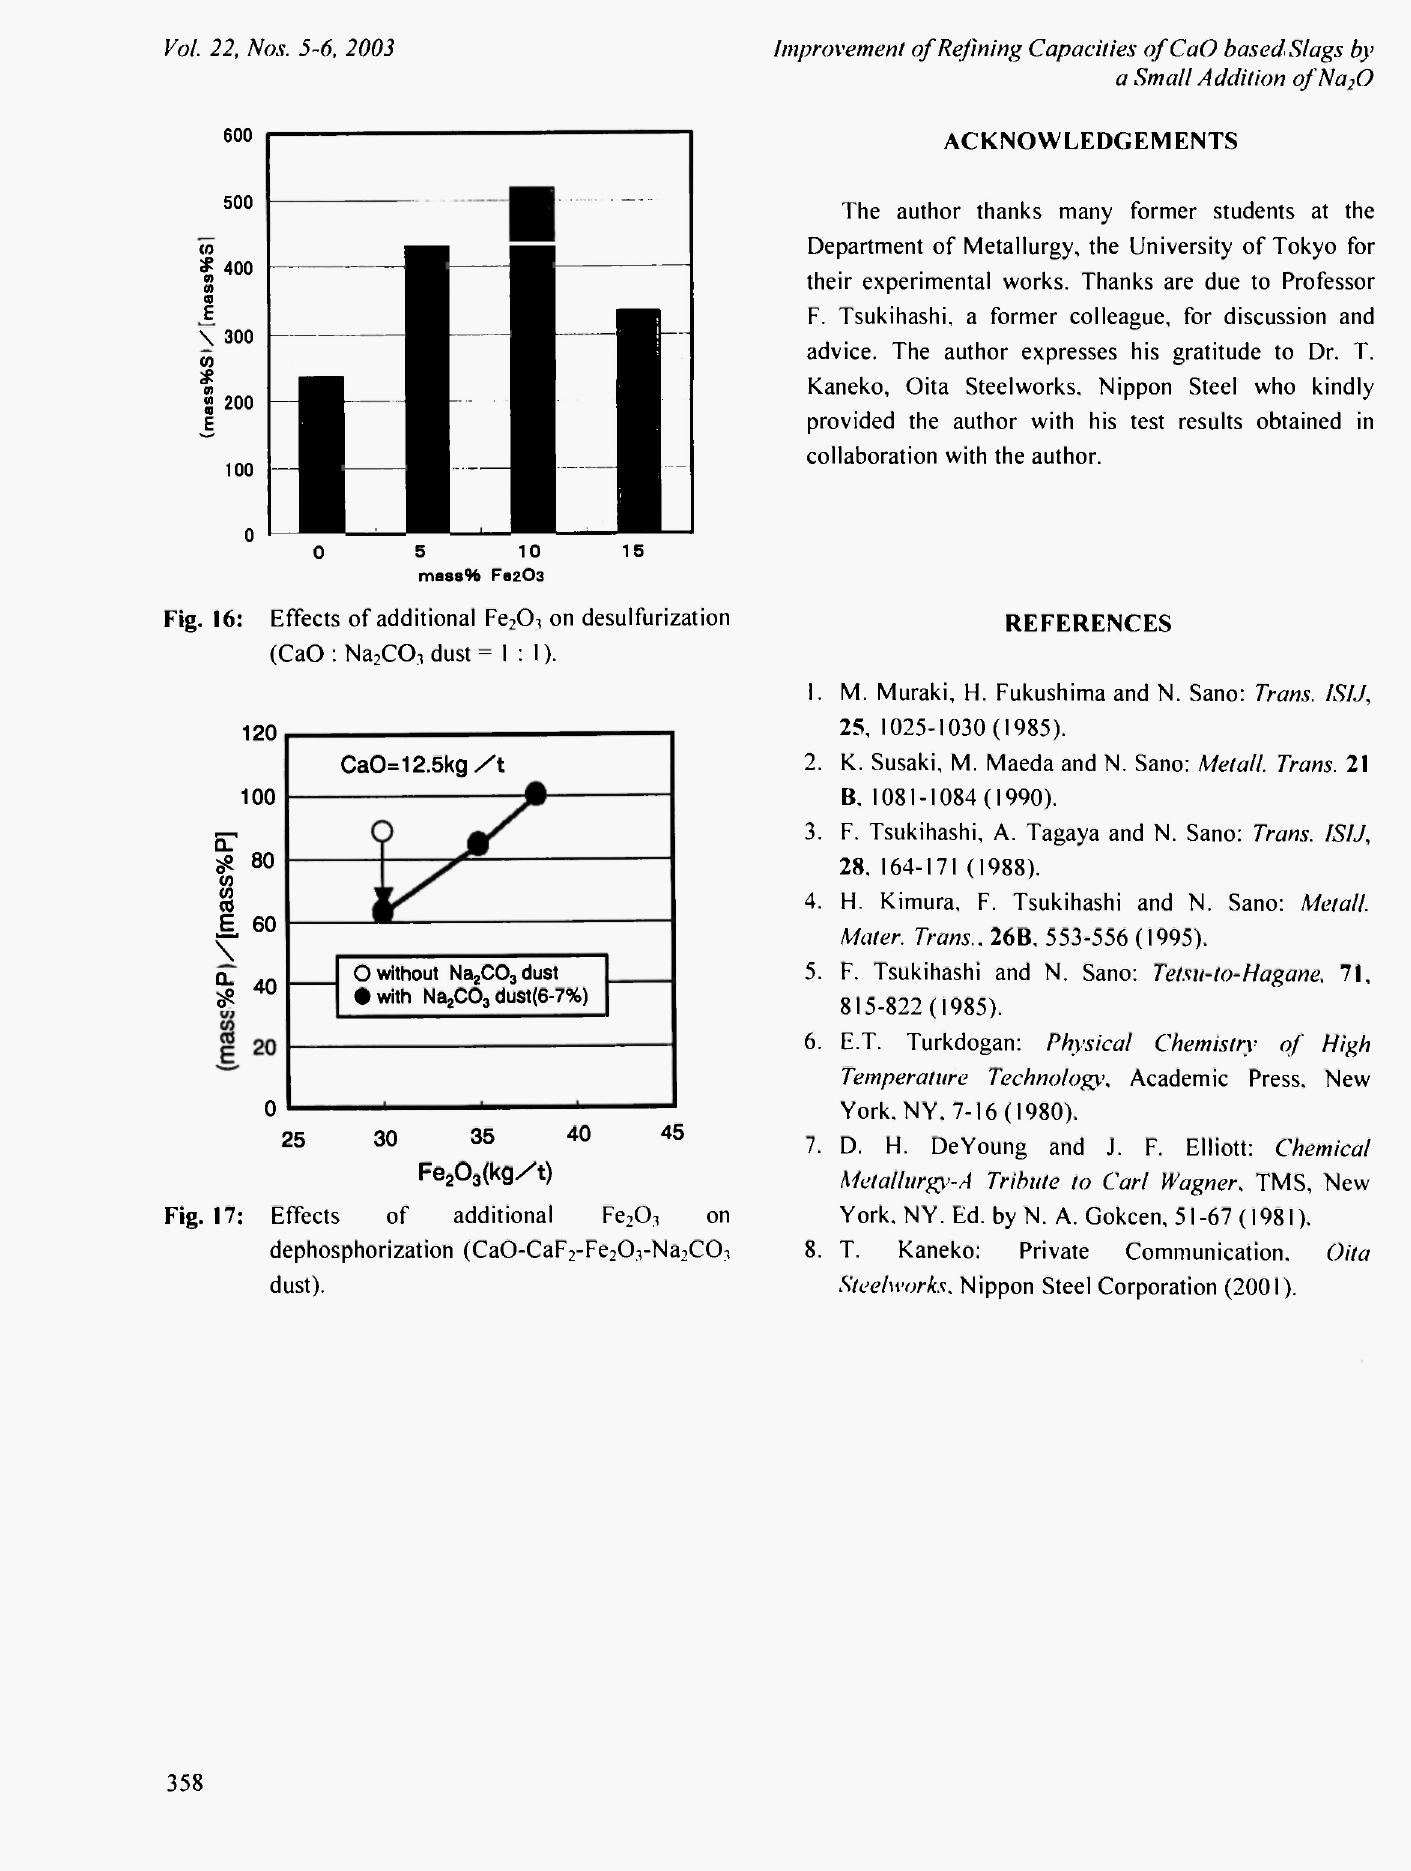
Fig. 16: Effects of additional Ρε 2 Οτ on desulfurization (CaO : Na 2 CO, dust = 1 : 1 ).